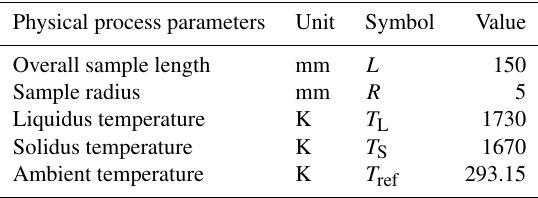
A peak q 0 value as 5 . 093 × 10 6 W m − 2 relates to a maximum power input of 400 W over a 10 mm diameter cross-section.